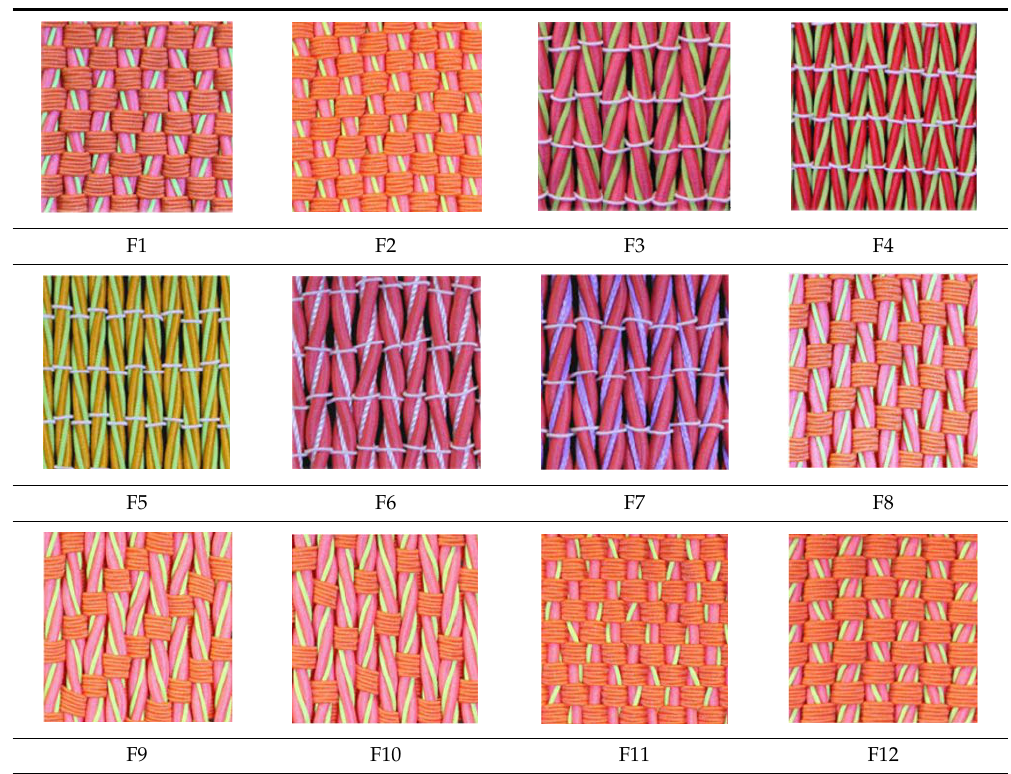
Table 2. Constructional characteristics of woven fabrics produced.